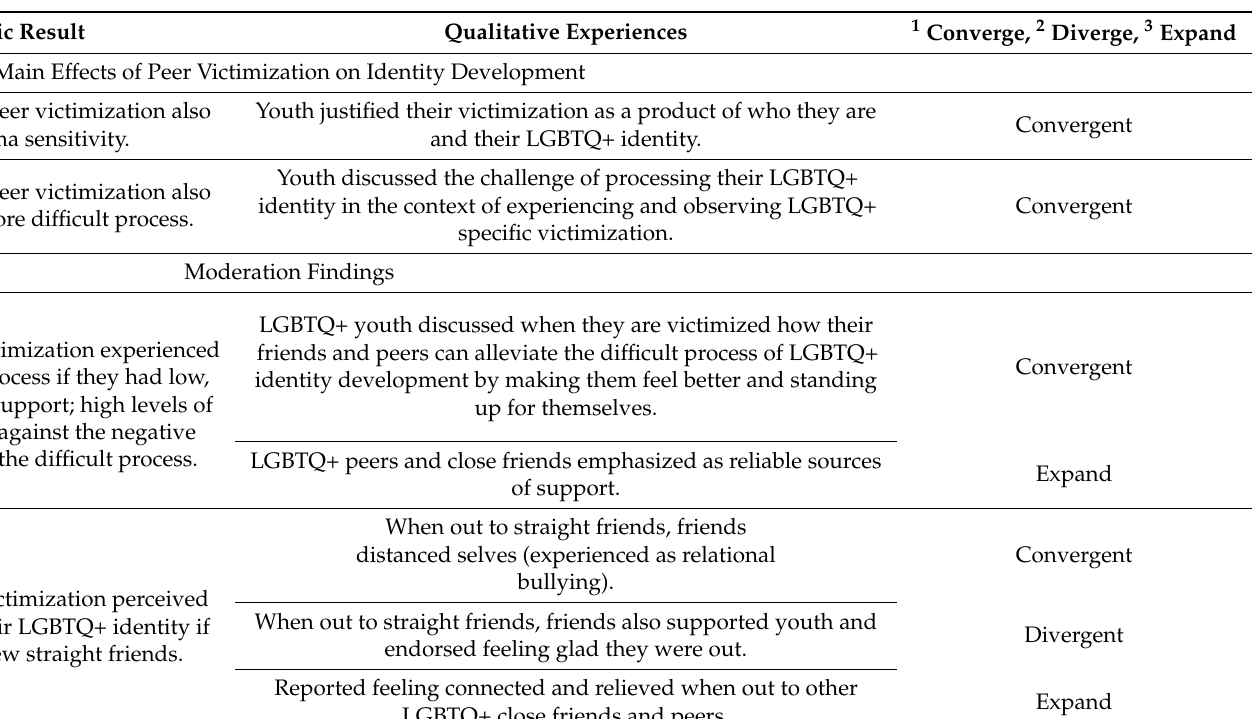
Table 4. Joint display of LGBTQ+ youth’s experiences of peer